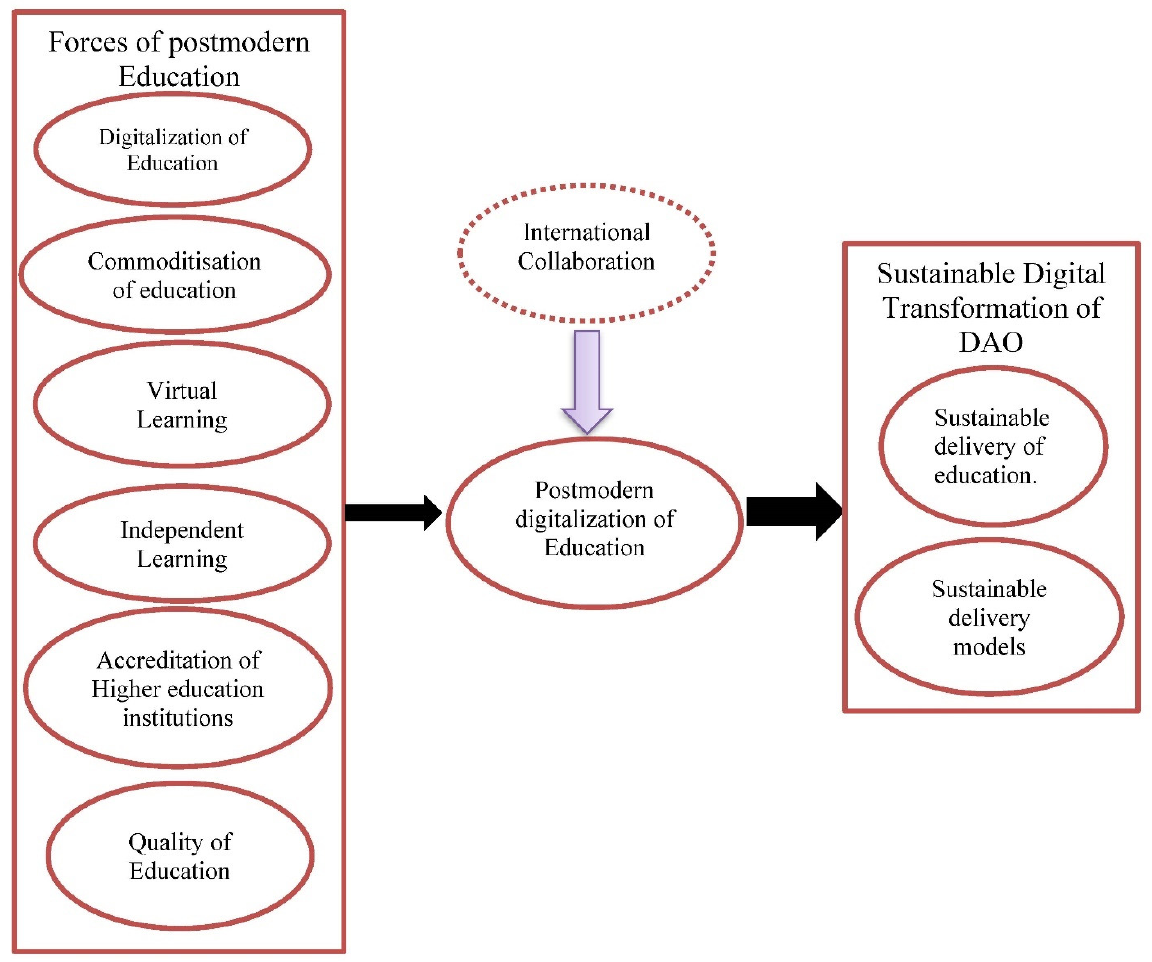
Figure 7. The nested fundamental model derived from the literature review. Source: Based on Dla č i ć et al. (2013); Bagci and Celik (2018) and Alalwan et al. (2021).